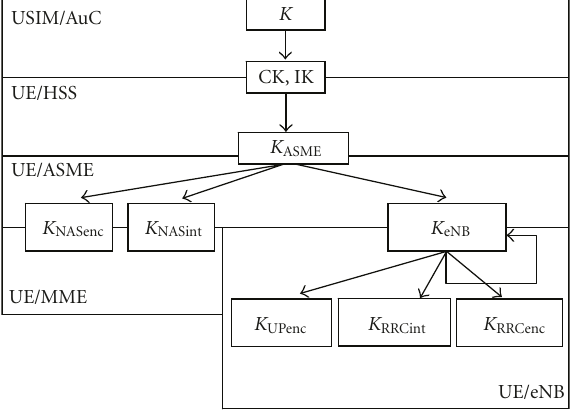
Figure 6: Key hierarchy generated in EPS-AKA.